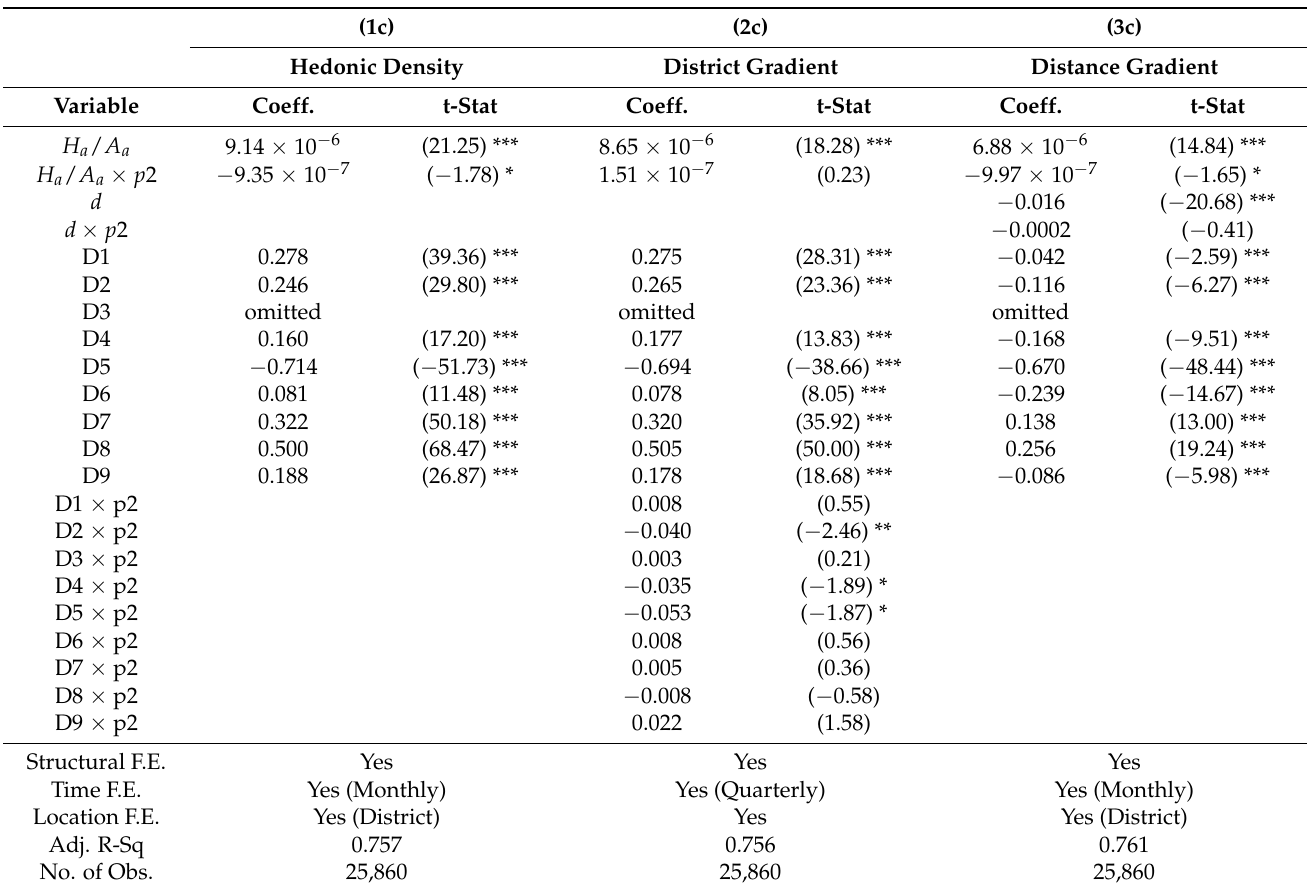
Table 4. Results of the density